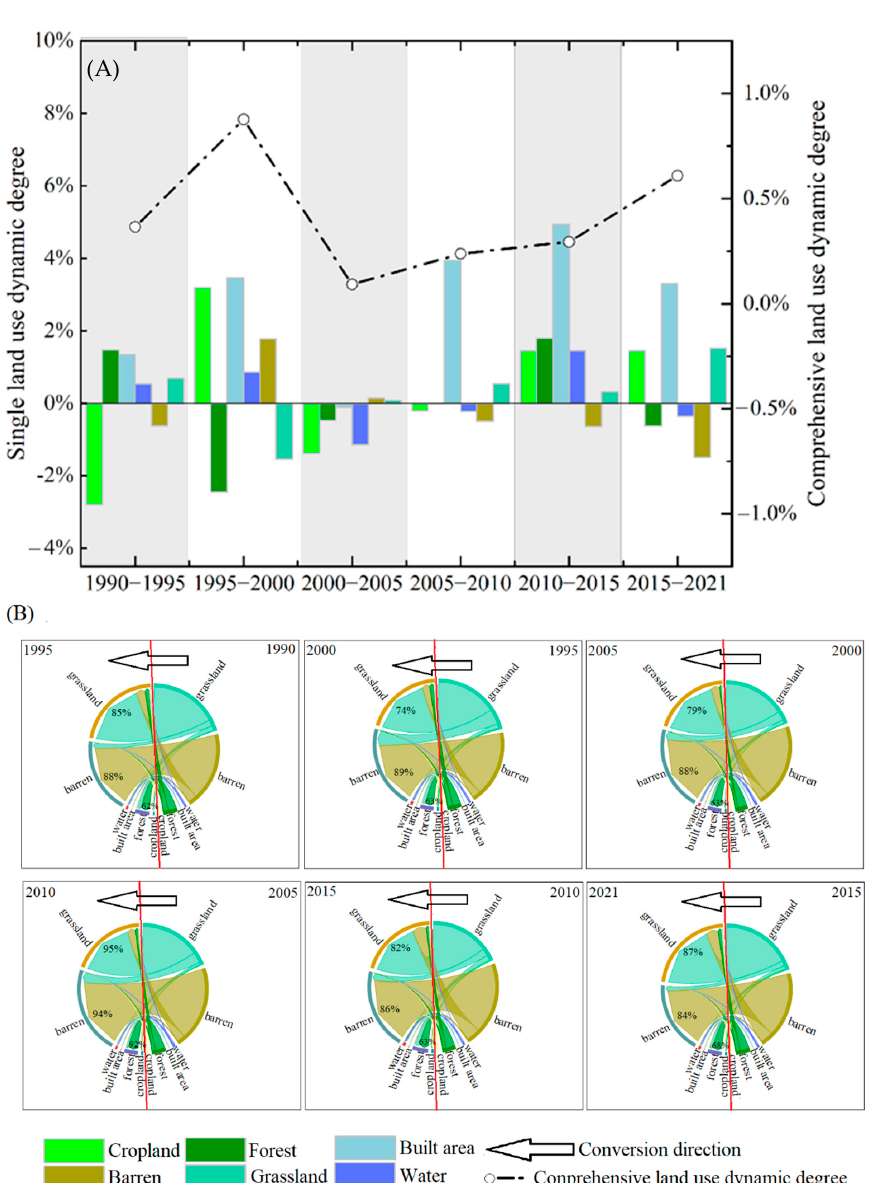
Figure 7. Dynamic degree ( A ) and transfer matrix Sankey diagram ( B ) of land use/cover change in Mongolia from 1990 to 2021. Note: In the figure, the land use change in different years is divided by red lines, the arrow direction represents the transfer direction of land use types, and the percentage indicates how many land use types have not changed during the two periods.